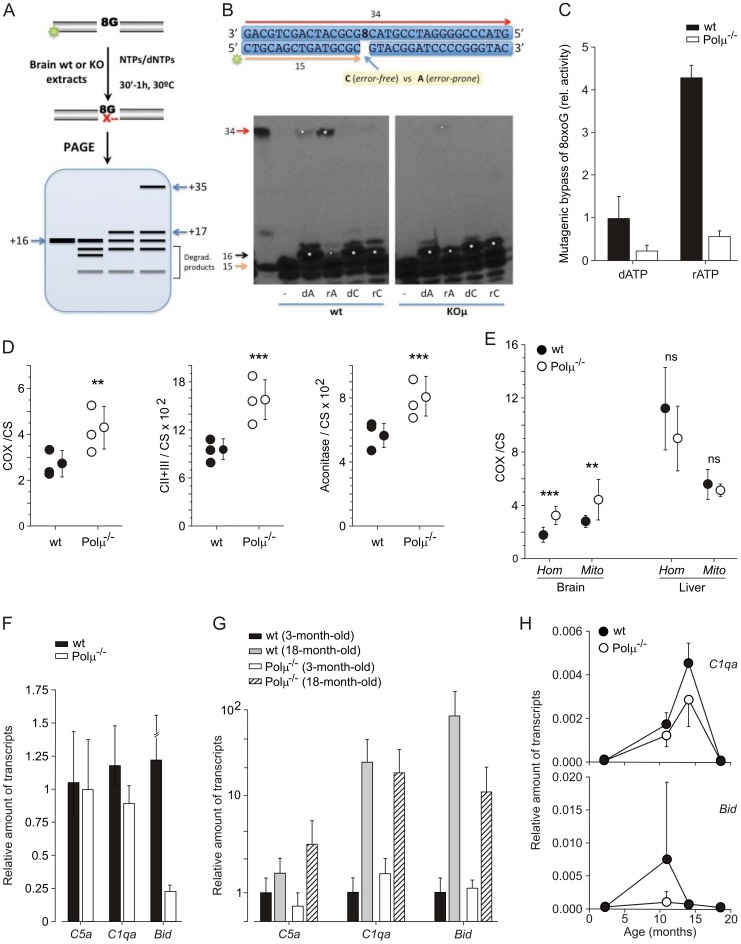
Polµ−/− mice brain shows a molecular profile compatible with a delayed aging phenotype.(A, B, C) Evaluation of 8oxoG bypass repair activity (tolerance) in brain (wild-type vs. Polµ−/−) extracts, using the indicated labeled-template primer (B). After incubation (30′–1 h, 30°C) with the clarified extracts (10 µg), with the addition of the indicated nucleotides (50 µM) and 1 mM MnCl2, products were recovered and resolved in 20% PAGE. The scheme (A) illustrates the mobility of the different expected products: the original labeled primer (+15) could appear intact or degraded by endogenous nucleases (degraded products); extended primers appear at positions (+16 or +17) if no ligation with the 5′-flank of the gap has occurred (short-patch repair), and at full-length repaired (or mutated) product (+34) if ligation did occur. (C). Densitometric analysis of full-length repaired (+34) product was carried out, for the reaction using dATP or rATP, and represented relative to the activity yield by wild-type brain extracts using dATP. (D, E) Evaluation of mitochondrial function in whole extracts (Hom) or mitochondrial purified fractions (Mits), in brain and liver of wild-type and Polµ−/− mice. Several relevant parameters (COX/CS, CII+CIII/CS, and aconitase/CS ratios) were monitored in brain (D) and compared with activity in liver (E). Differences were considered statistically significant at P<0.05. *P<0.01; **, P<0.001; ***, P<0.0001 and ns, non-significant. (F, G, H) qRT-PCR analysis (F) of genes found to be differentially expressed in brain of old Polµ−/− mice (Figure S8). Evolution of gene expression at different ages (G, H). All qRT-PCR analyses were carried out in triplicate and normalized to (36B4 or β-actin), and represented as the relative level of expression of the indicated gene.